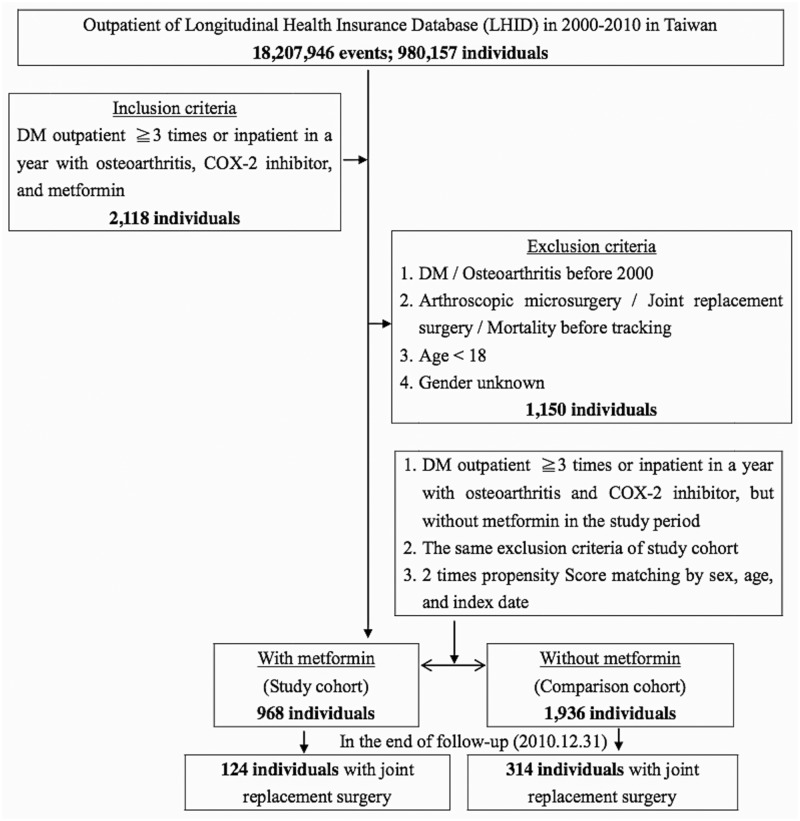
The flowchart of study sample selection from National Health Insurance Research Database in Taiwan.DM = Diabetes mellitus: ICD-9-CM 250; Osteoarthritis: ICD-9-CM 715; COX-2 inhibitor / Metformin: ≧ 90 days. Arthroscopic microsurgery was including synovectomy or/and capsulotomy (NHIRD order code 64054B-64057B), partial meniscectomy (NHIRD order code 64218B), and arthroscopic surgery (NHIRD order code 64243B-64244B). Joint replacement surgery was including osteosynthesis (NHIRD order code 64038B-64040B), total hip replacement (NHIRD order code 64162B-64168B), partial joint replacement (NHIRD order code 64169B-64170B), arthroplasty (NHIRD order code 64171B-64177B), arthrodesis (NHIRD order code 64178B-64183B), removal of prosthesis (NHIRD order code 64198B-64200B), revision replacement (64201B-64202B), and girdle stone procedure of hip (NHIRD order code 64203B).